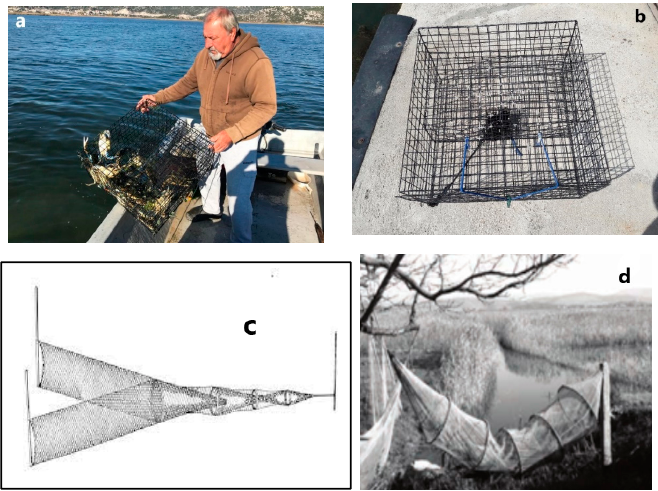
Figure 2. Mr. Stanko Glamuzina, retired oyster fisher from Louisiana, USA ( a ), and sampling gear: ( b ) American wire crab trap/and ( c ) and ( d ) traditional eel fyke net ( a , b , c , d : photos by Branko Glamuzina).